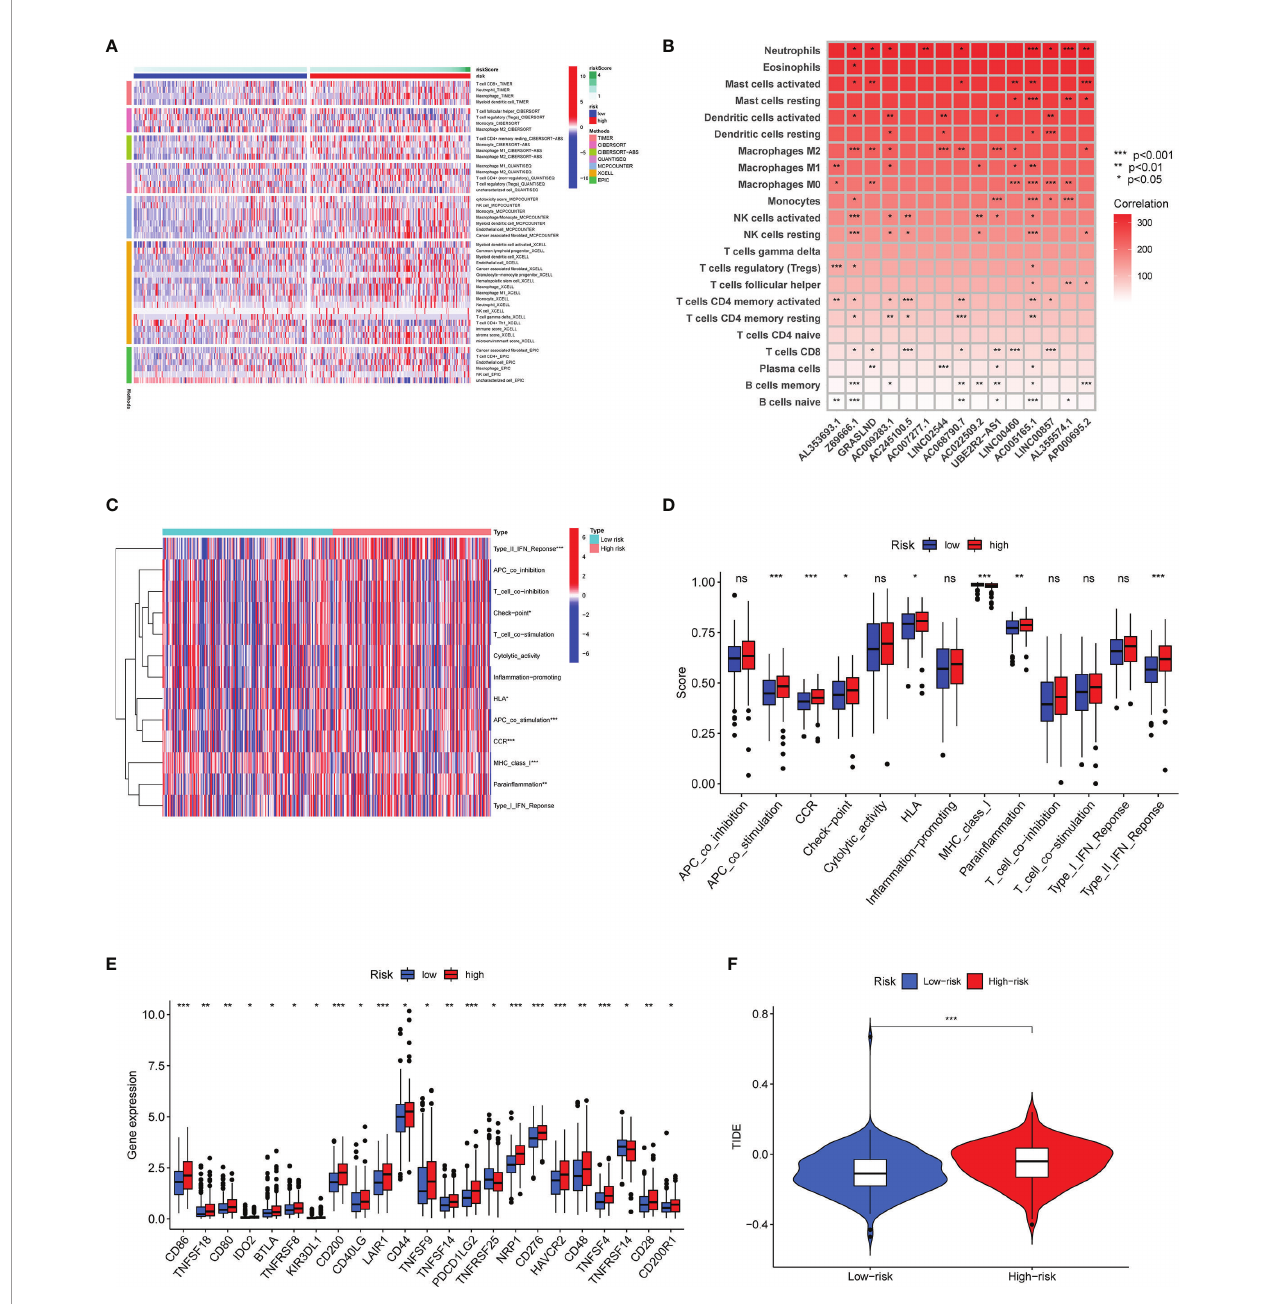
FIGURE 10 | Differential immune features in the high-risk and low-risk subsets. (A) The association between in fi ltrating immune cells and risk scores using seven algorithms. (B) The correlation between the expression of 15 matrisomal-related lncRNA-based signature and in fi ltrating immune cells using the CIBERSORT algorithm. (C, D) The heatmap and boxplot show the correlation analysis between immune functions and risk score. (E) Box plots revealed the differential expression of the immune checkpoint genes between two groups. (F) Correlation of risk score and TIDE score in different risk subgroups. ns no statistical signi fi cance, * p < 0.05, ** p < 0.01, and *** p <